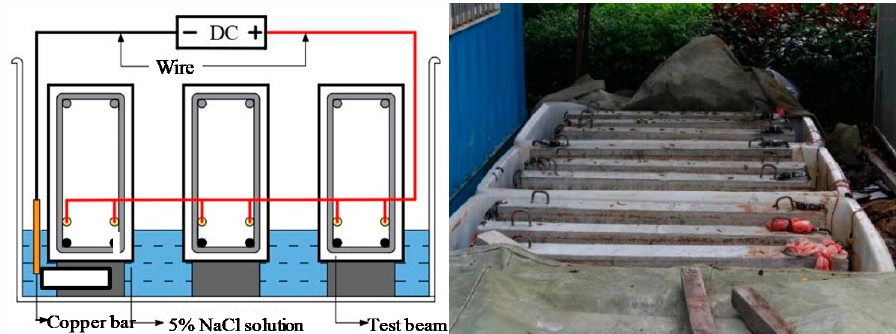
Figure 4. Setup of the electric corrosion experiment.